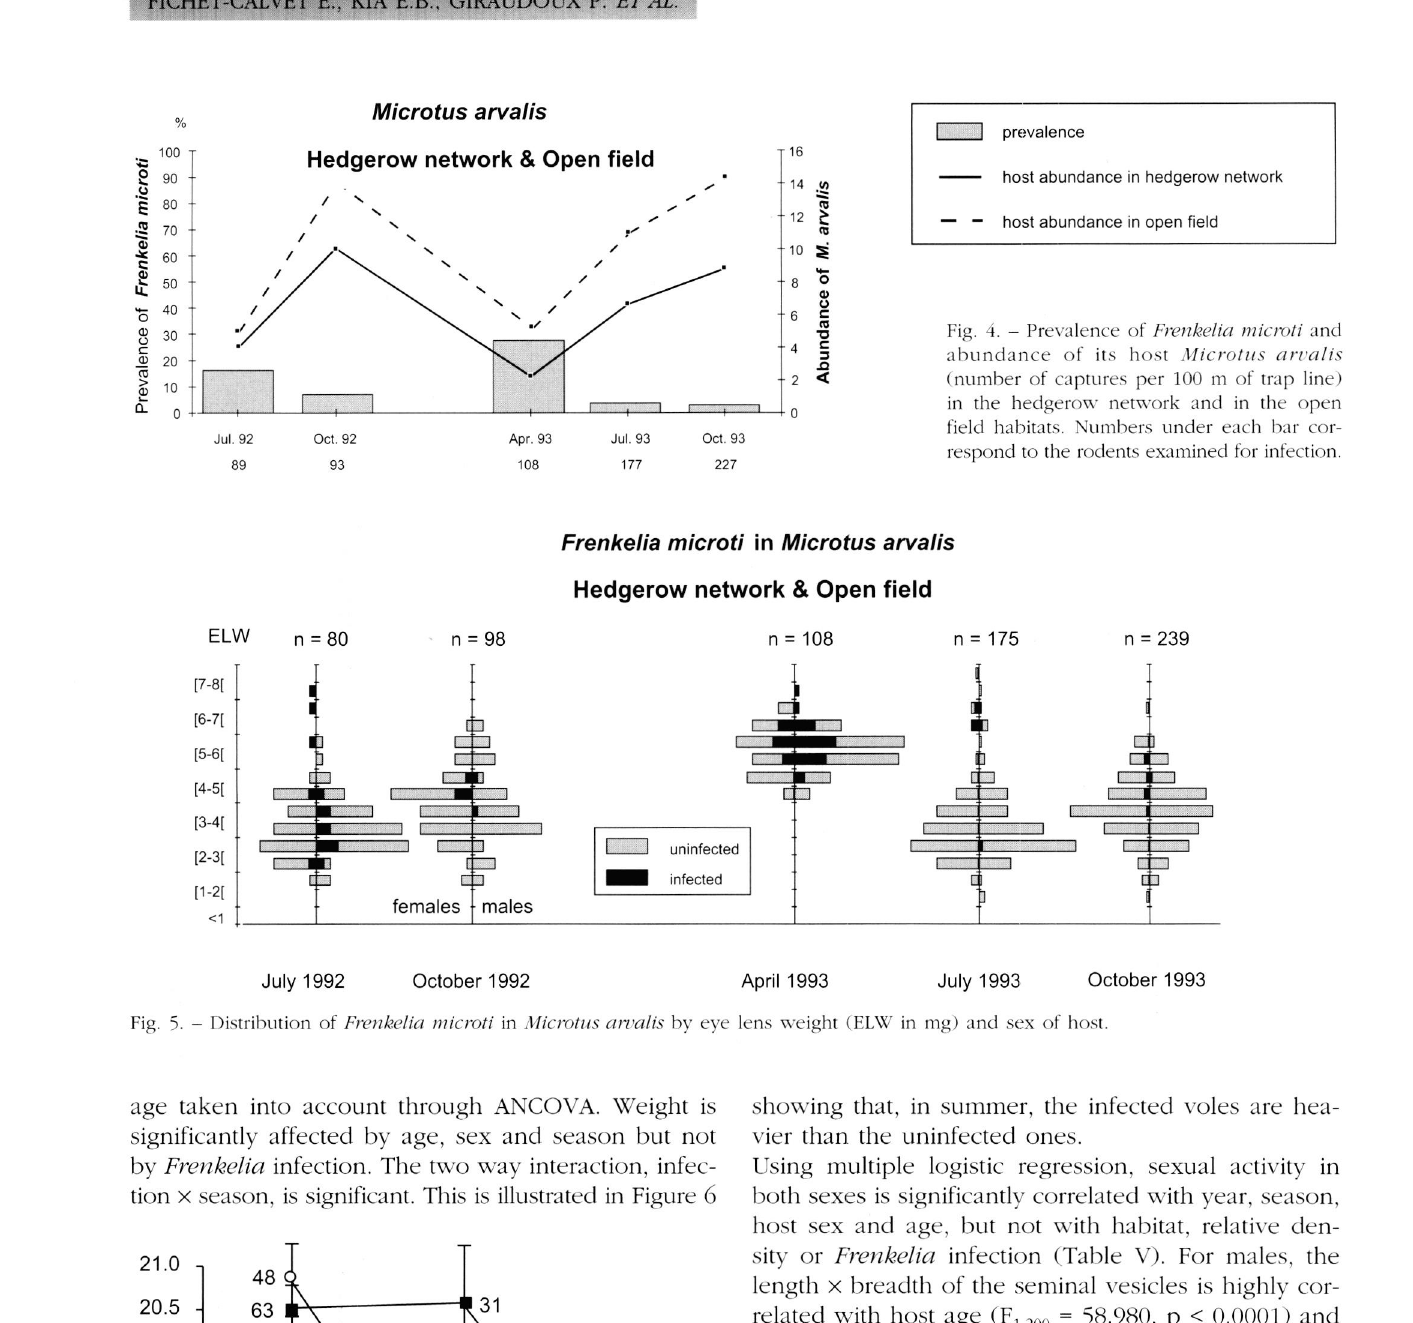
Fig. 5. - Distribution of Frenkelia microti in Microtus amalis by eye lens weight (ELW in mg) and sex of host.